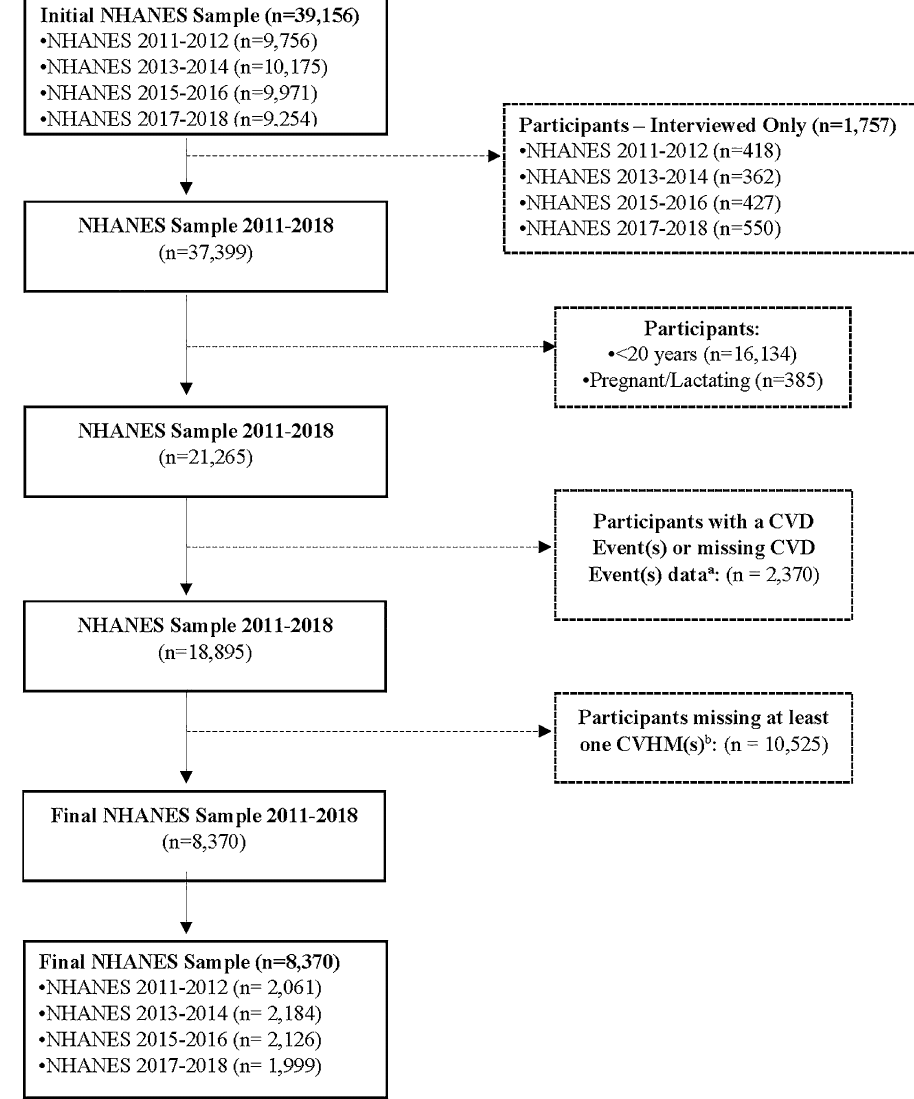
Figure 1. Flow chart of participant selection. NHANES National Health and Nutrition Examination Survey, CVD cardiovascular disease, CHF coronary heart failure, CHD coronary heart disease, ANG angina/angina pectoris, HAT heart attack, CVHM cardiovascular health metric, PA physical activity, SS smoke status, BMI body mass index, BP blood pressure, CHOL total cholesterol, FPG fasting plasma glucose. a CVD events includes CHF, CHD, ANG, HAT, Stroke. b CVHM includes PA, SS, BMI, BP, CHOL,